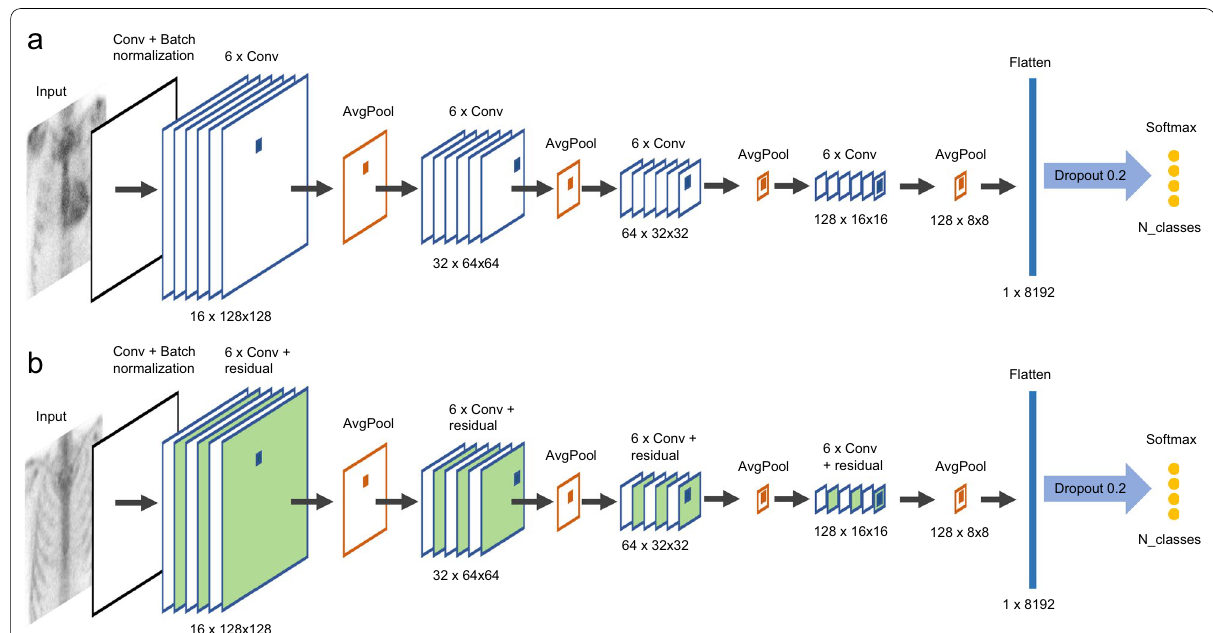
Fig. 3 Architectures for Linear a and Residual b models. In b , convolutional layers including skip connections are shown in green. The dimensionality of each layer is shown below the layers. N_classes refers to the number of classes, which was either 4 or 2 depending on the classification